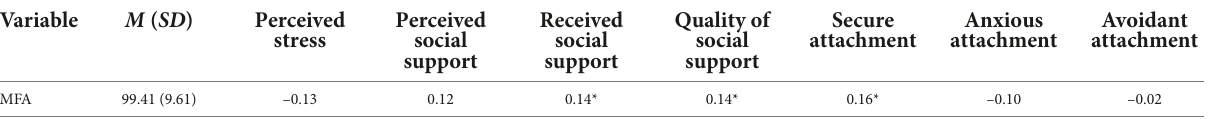
TABLE 6 Pearson’s linear correlation coefficient for the relation between maternal–fetal attachment (MFA), social support, and perceived stress and maternal adult attachment. Variable